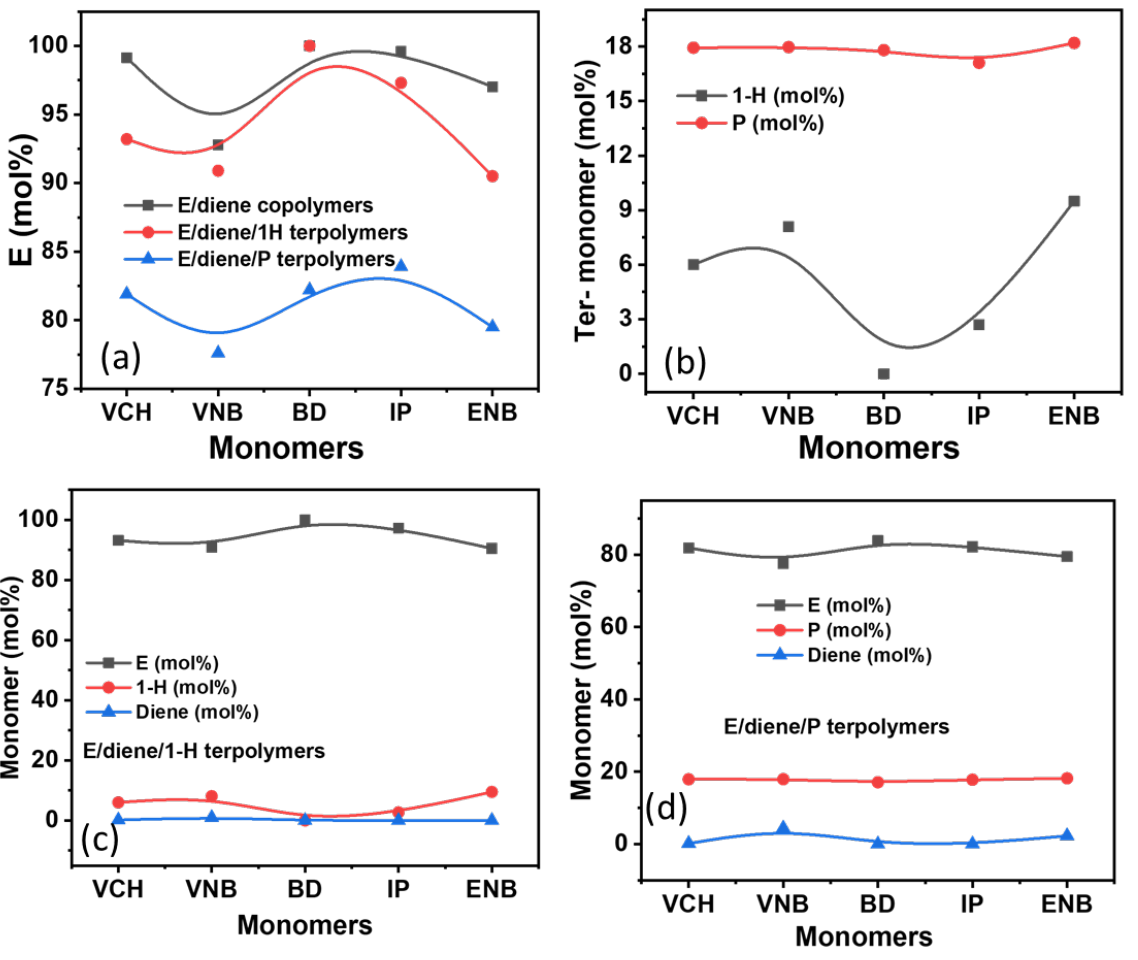
Figure 2. ( a ) Plots of E content in E/diene, E/diene/1-hexene, and E/diene/propylene polymerizations, ( b ) content of propylene and 1-hexene in E/diene/1-hexene and E/diene/propylene, ( c ) comparison of the content of E, diene, and 1-hexene, ( d ) comparison of the content of E, diene, and propylene. Table 2. E/diene, E/diene/1-hexene, and E/diene/propylene polymerization catalyzed with ( rec